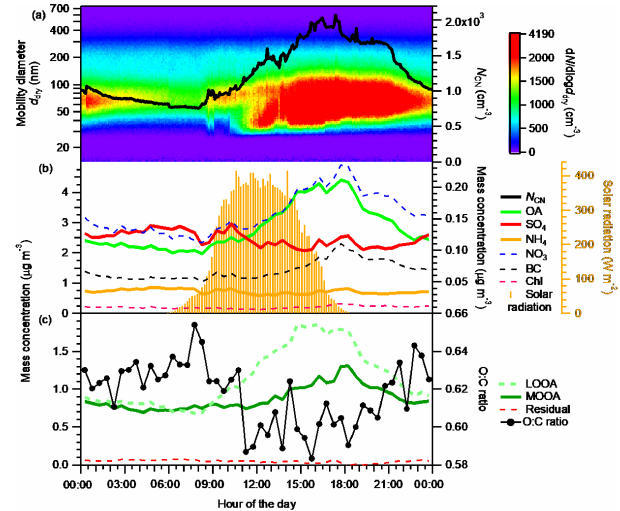
Figure 2. Diurnal variations in (a) number-size distribution (im- age plot) and number concentration (NCN, right axis) of ambient aerosols; (b) the mass concentrations of OA, SO 4 , and NH 4 (left axis), and NO 3 , BC, and Chl (right axis in black); and (c) the mass concentrations of LOOA, MOOA, and the residual, and the O : C ratio of bulk OA (only data with m org > 0 . 3mgm − 3 are included). (A box-and-whisker plot of the diurnal variation in O : C ratio is presented in Fig. S19.) The diurnal variation in solar radiation is superimposed in panel (b) . All data presented are averages for the entire study